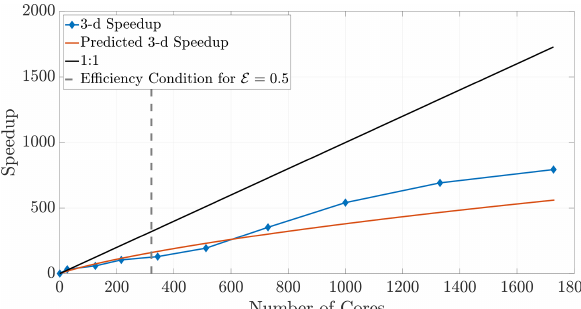
Figure 15. Poorly chosen core numbers may result in severely non- square tilings that can degrade speedup performance, despite em- ploying more computational